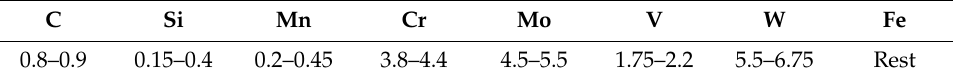
Table 1. Elemental composition (wt.%) of W6Mo5Cr4V2 high-speed steel